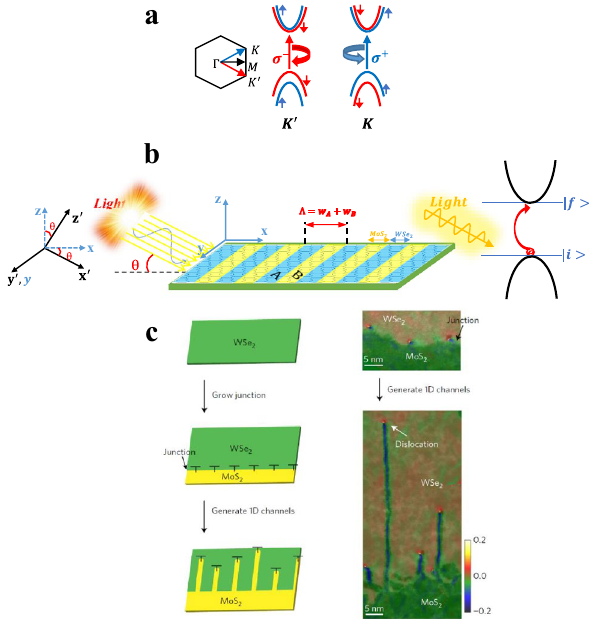
Figure 1. ( a ) Comparison of electronic structure in K and K ′ valleys for TMDC-PSL; ( b ) Schematic diagram of the impinging light on TMDC-PSL and interband transition. A, B indicate two ML-TMDCs; MoS 2 and WSe 2 , respectively. ( c ) Formation of 1D channels . Left column, Schematic of the patterning process guided by misfit dislocations (marked as ‘T’) at the MoS 2 –WSe 2 lateral heterojunction. Right column Atomic-resolution ADF-STEM images overlaid with their ε xx strain maps identifying the periodic dislocations at the interface of MoS 2 and WSe 2 and the 1D channels created by chemically driven migration of the interfacial dislocations as additional S and Mo atoms are added ( c ) 13